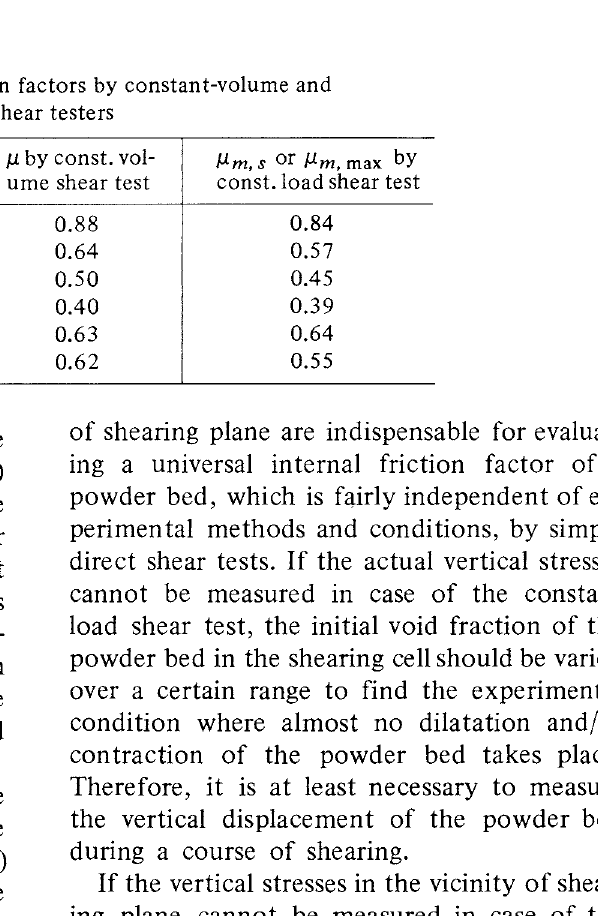
Table 3 Internal friction factors by constant-volume and constant-load shear